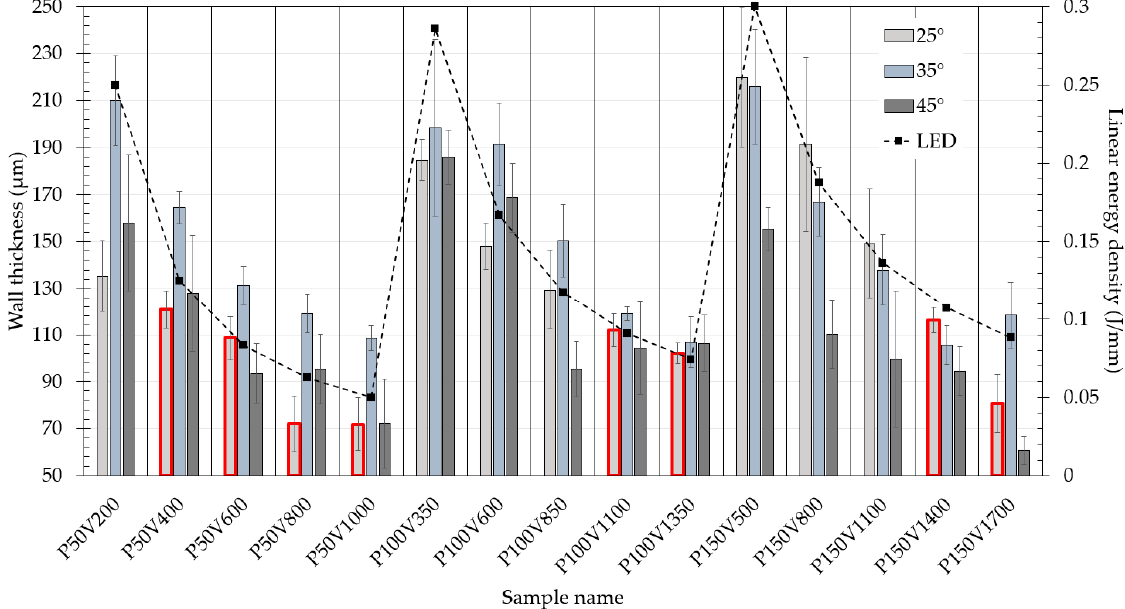
Figure 7. Dependence of wall thickness on linear energy density for inclined walls.